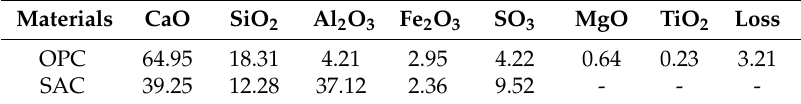
Table 1. Chemical compositions of cements used in this study (wt.%).